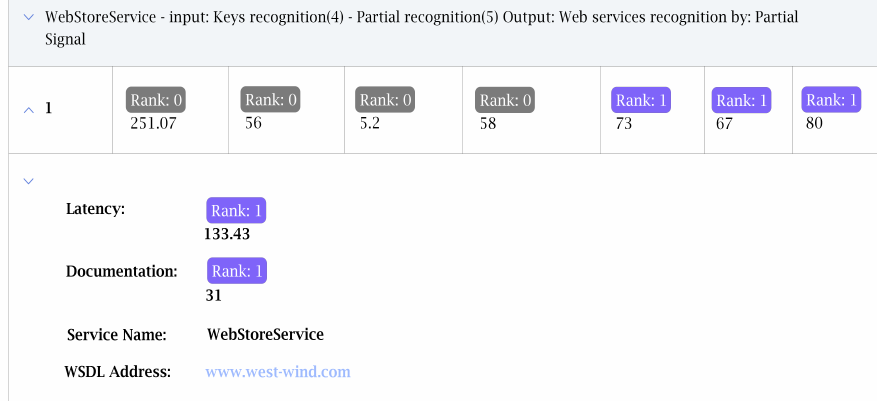
Figure A3. WebStoreService recognition example.